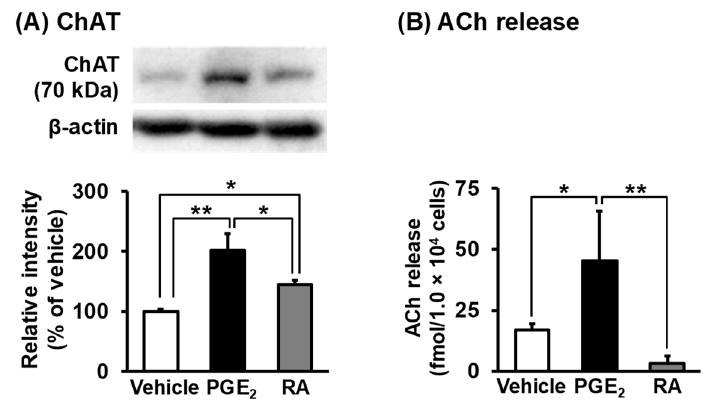
Figure 7. Synthesis and release of acetylcholine (ACh) in NSC-34 cells. Undifferentiated NSC-34 cells were treated with a vehicle (EtOH), 30 μ M PGE 2 for 2 days, or 10 μ M RA for 7 days. ( A ) The photograph shows a representative result of the Western blotting of Choline acetyltransferase (ChAT) with β -actin as an internal marker. The open arrowhead indicates a nonspecific band recognized by the antibody. Graph shows the relative densities of bands on the blots quantitatively estimated by Scion imaging software. Each value represents the mean ± SD ( n = 3). * p < 0.05, ** p < 0.01. ( B ) Graph shows the ACh concentration normalized per 1.0 × 10 4 cells in each treatment group. Each value represents the mean ± SD ( n = 4). * p < 0.05, ** p < 0.01.